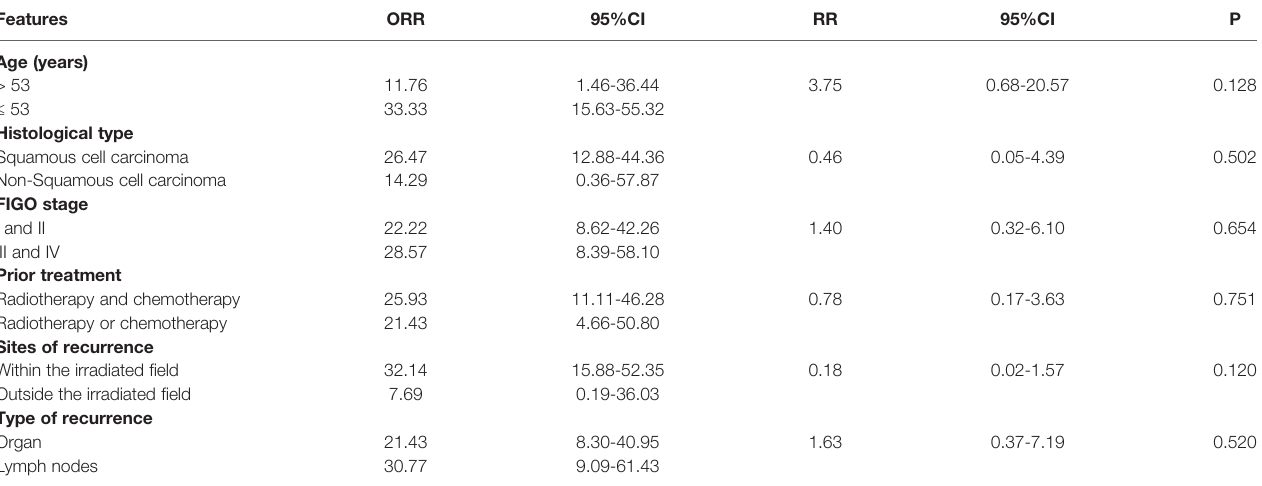
TABLE 3 | Subgroup analysis for ORR in patients treated with Anlotinib.